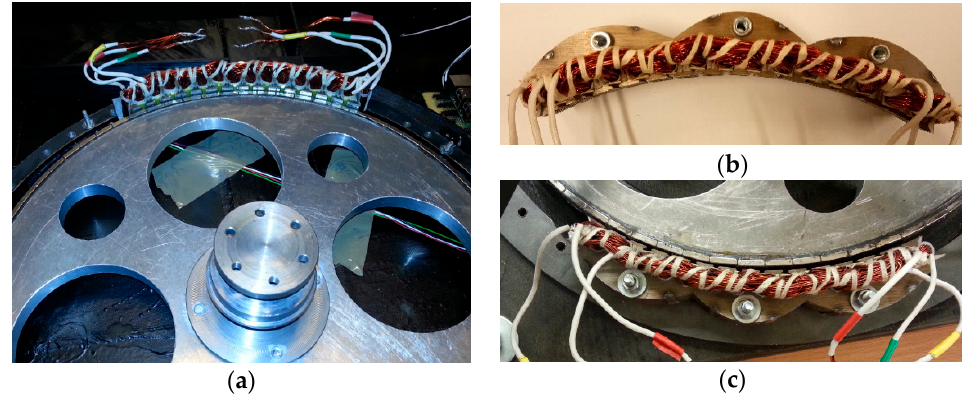
Figure 7. Details of evaluative design of segmented motor: ( a ) wheel shaft and motor rotor, ( b ) sole segment, ( c ) fastening of segment.